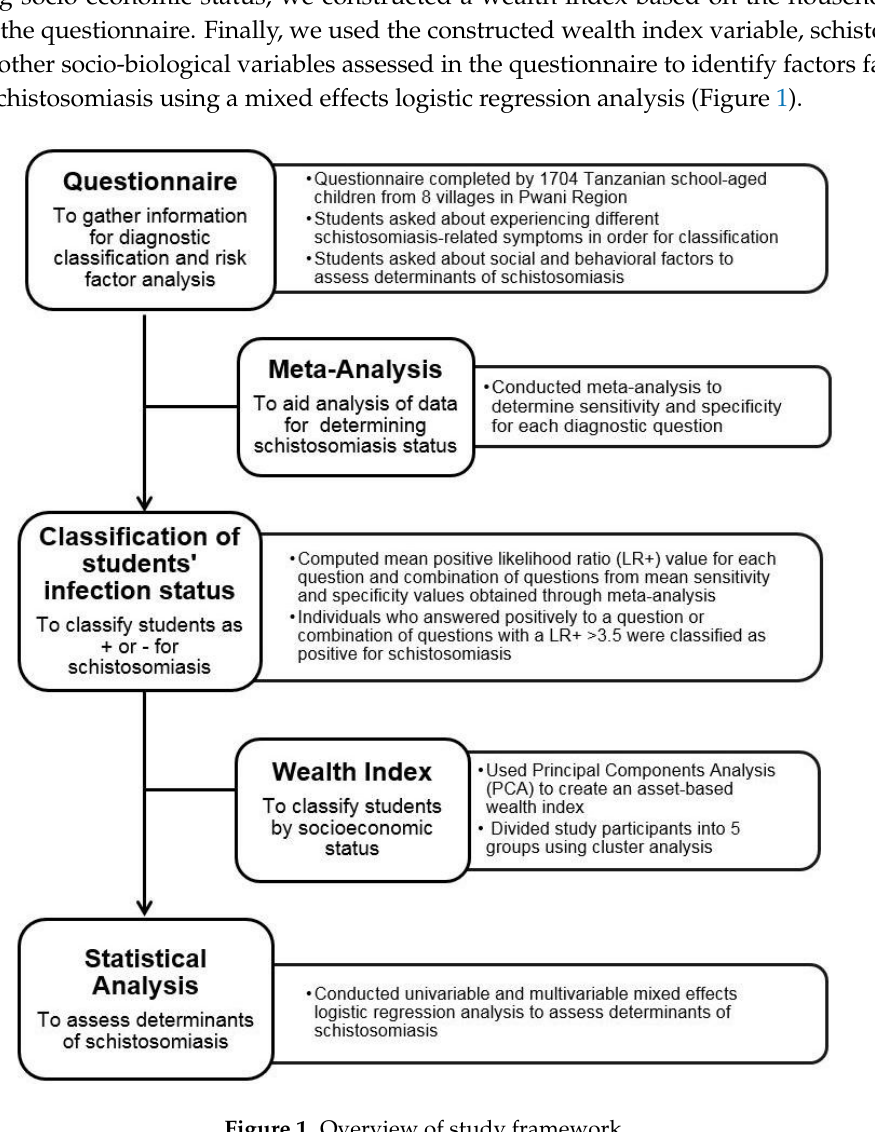
Figure 1. Overview of study framework.